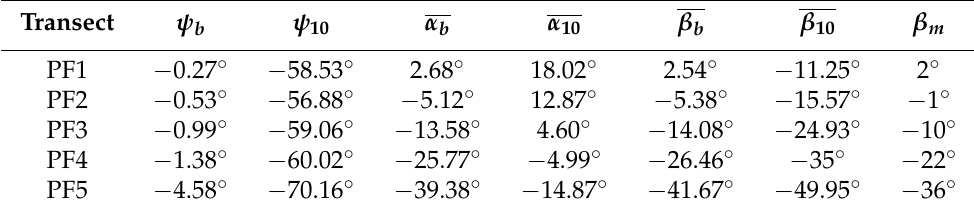
Table 1. Values of ψ b , ψ 10 , α b , α 10 , β b , β 10 , and β m . β m is the beach orientation measured on Google Earth images.